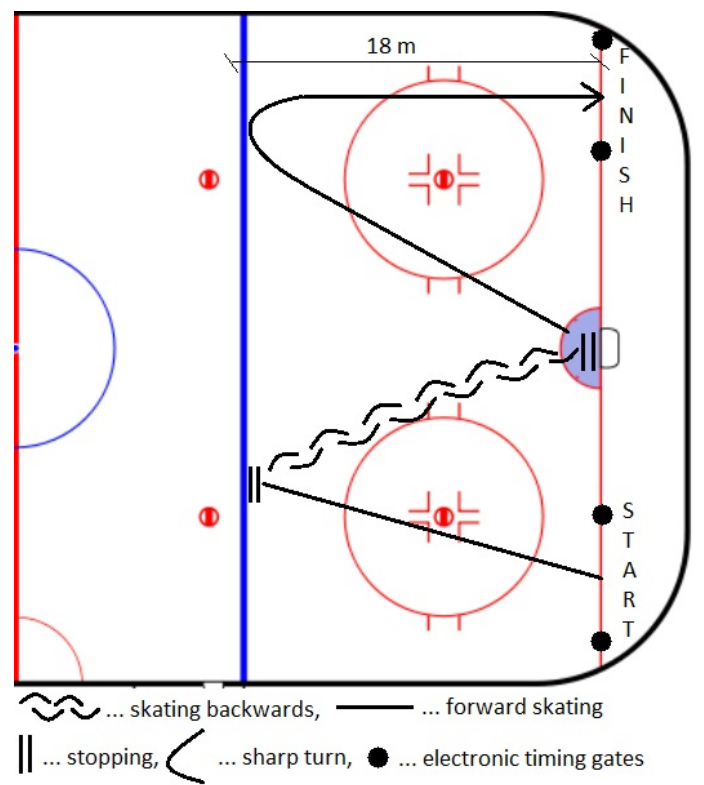
Figure 1. Graphic illustration of the specific on-ice repeated- sprint ability